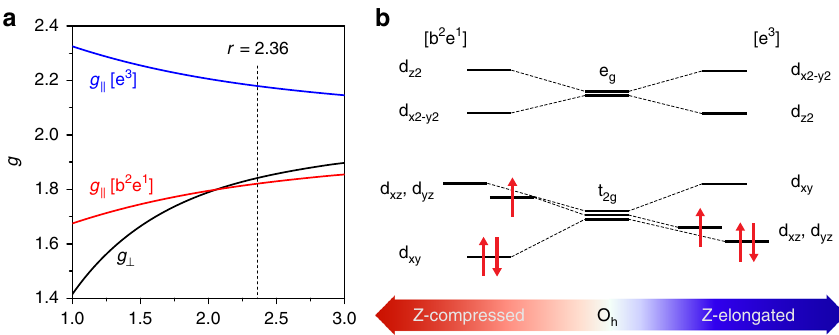
Fig. 5 Evaluation of g -values and corresponding d -orbital con fi gurations of the Mn(IV) species. a Plot of g -values for the [b 2 e 1 ] and [e 3 ] con fi gurations as a function of r . b Qualitative d -orbital splitting pattern for tetragonally compressed ([b 2 e 1 ] con fi guration) and elongated ([e 3 ] con fi guration) low-spin octahedral Mn(IV) centers.